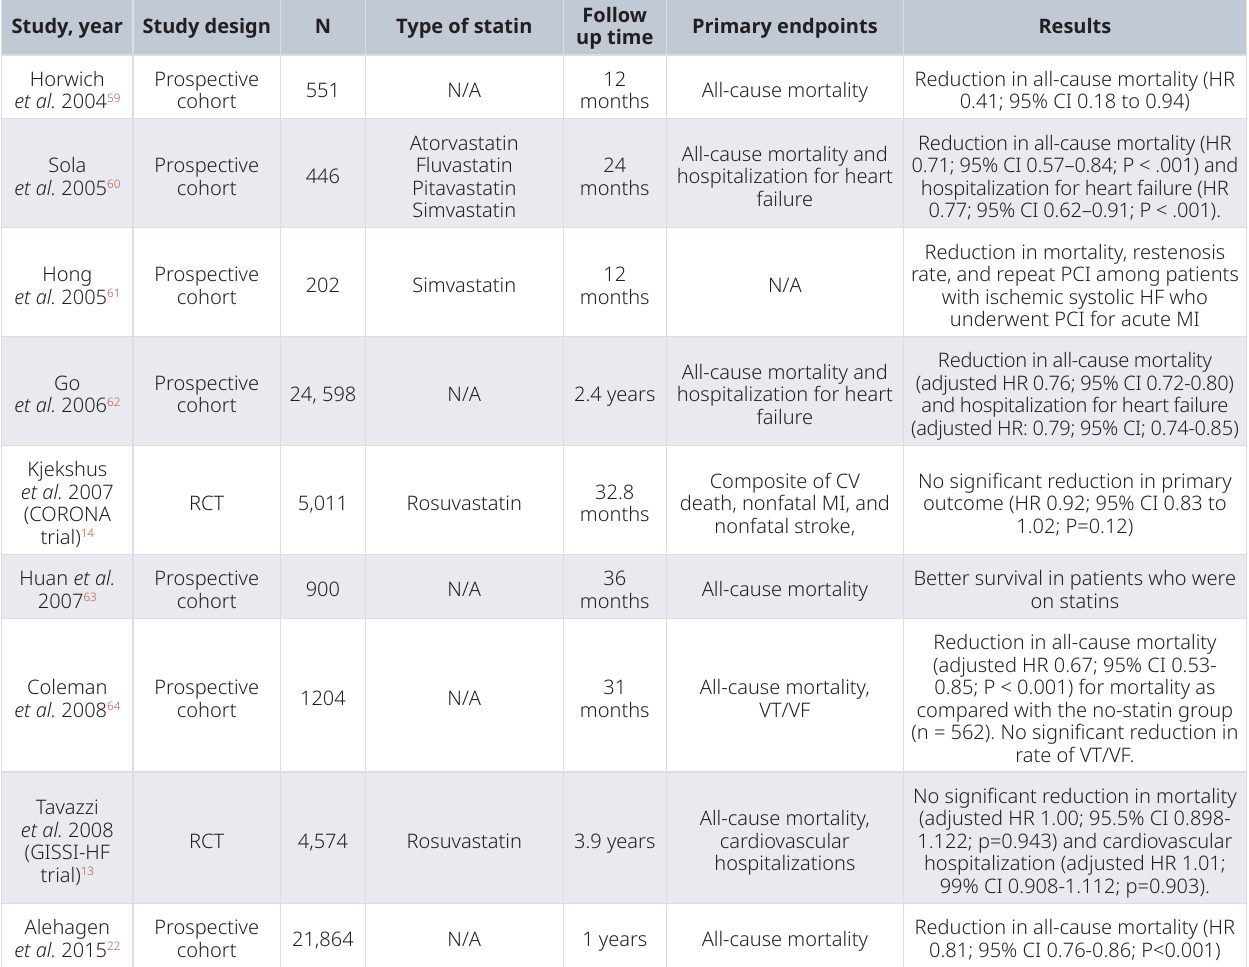
Table 2. Relevant clinical studies with the primary objective of determining the effects of statins in patients with heart failure with reduced ejection